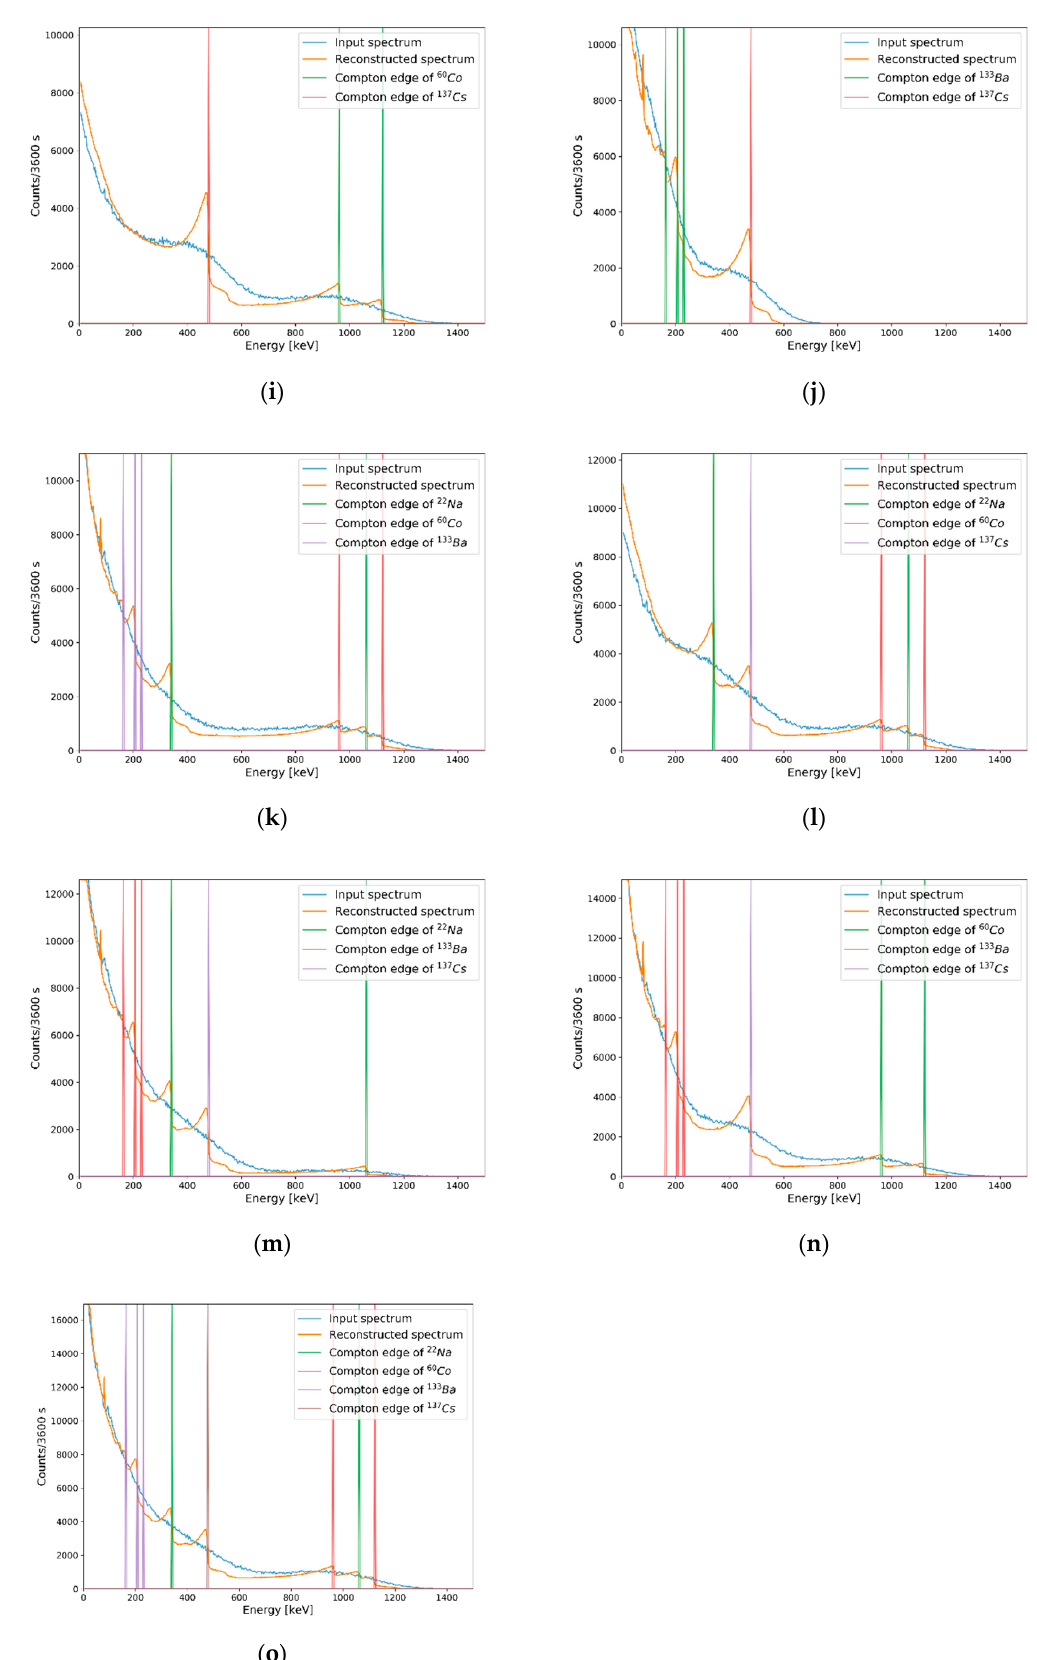
Figure 8. Results of Compton edge reconstruction for experimental data. Each figure